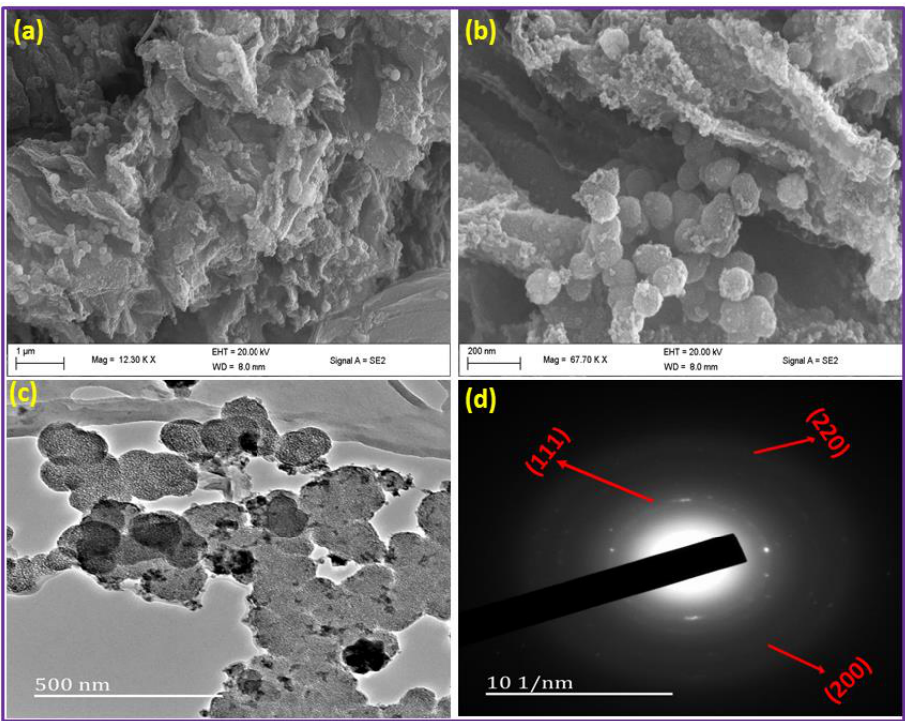
Figure 3. Different magnifications of SEM image ( a , b ), TEM image ( c ), and SAAD pattern ( d ) of 5Cu(0)-AAPTMS@RGO-MCM-41 sample. High-resolution images of (a) 5Cu(0)-AAPTMS@RGO-MCM-41 and (b) histogram of